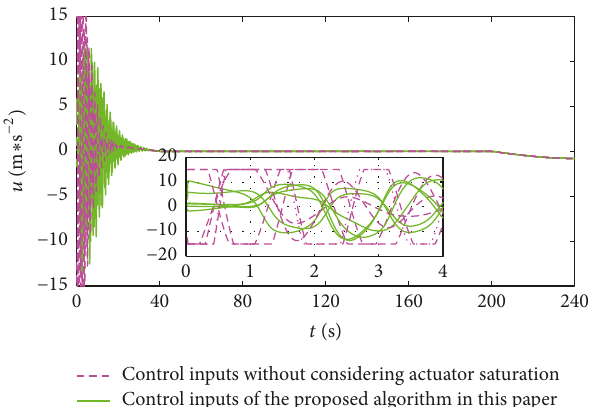
Figure 8: Performance comparison with actuator saturation.